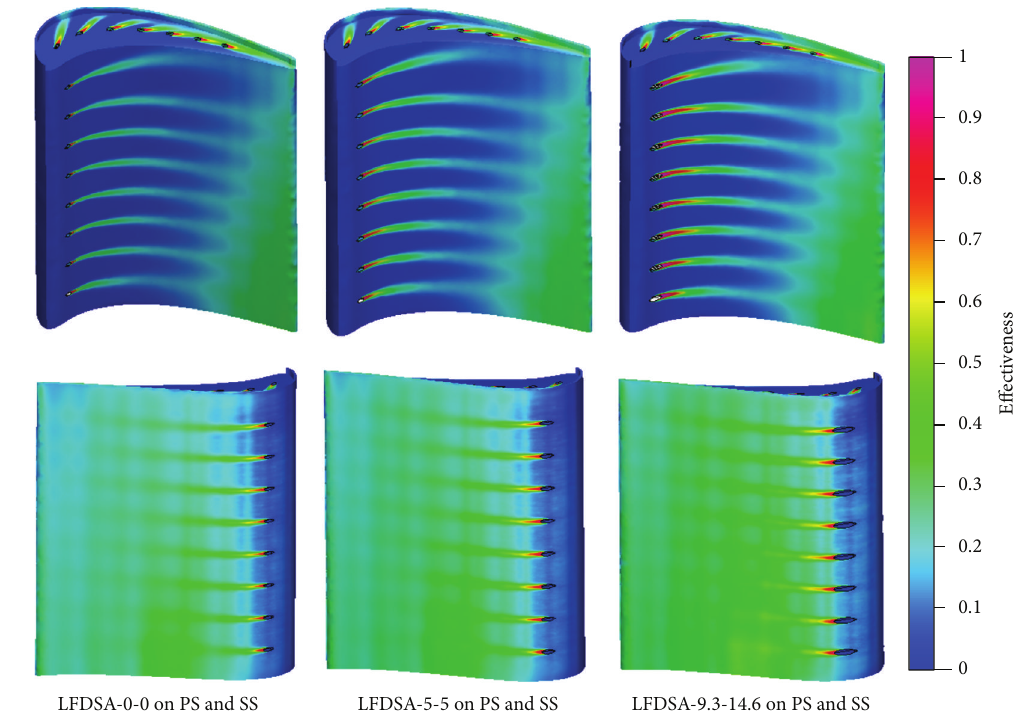
Figure 35: Effectiveness contours on the pressure and suction sides for different hole